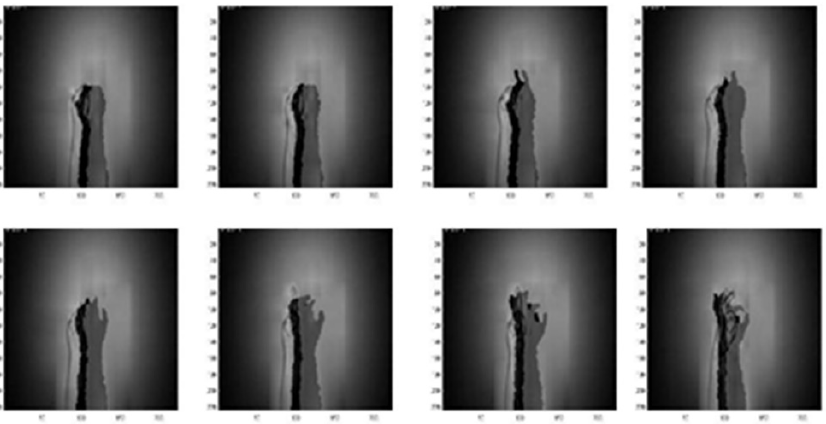
Figure 17. The fused image of two different sensor modalities of “Depth-Grayscale” and “CCD RGB-IR” by wavelet image fusion with min-max operations for VGG-16 CNN deep learning and recognition (e.g., the hand gesture intention action, Action 1).